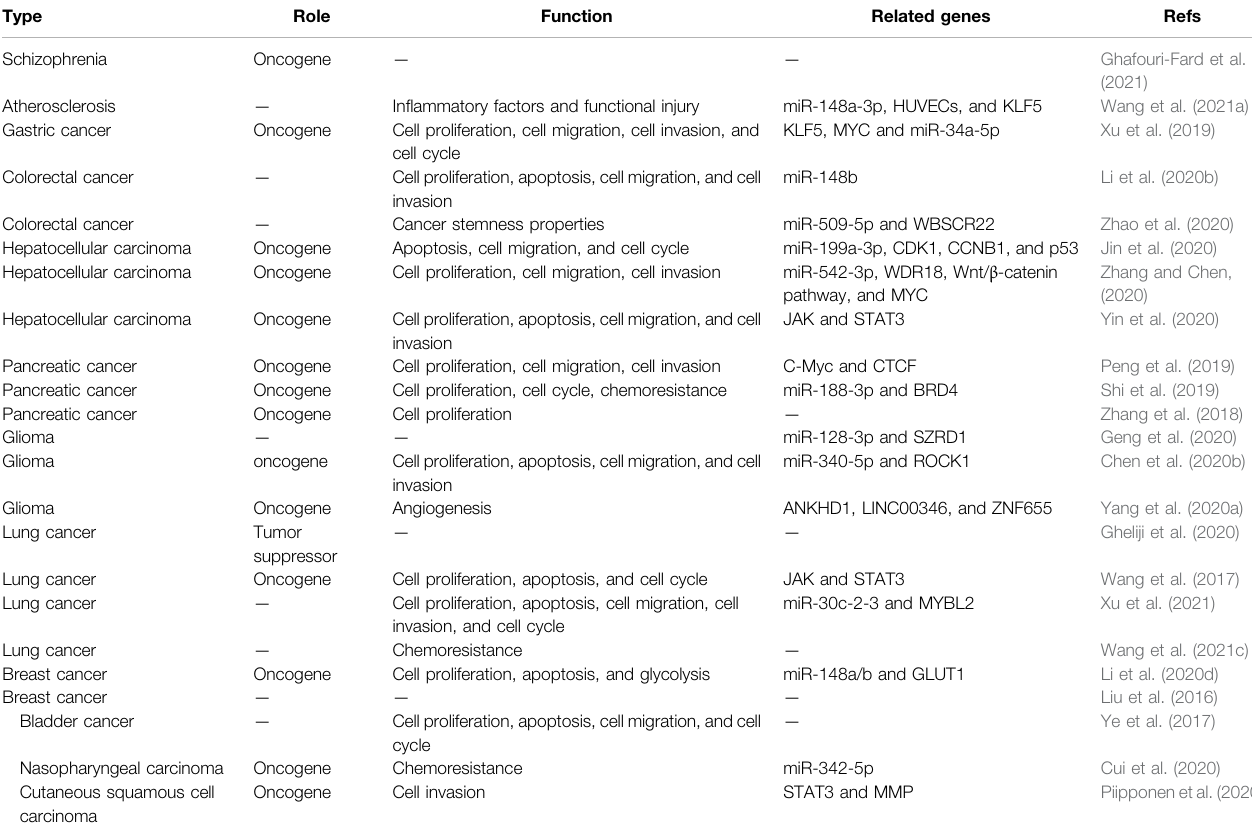
TABLE 2 | The functions and mechanisms of LINC00346 in